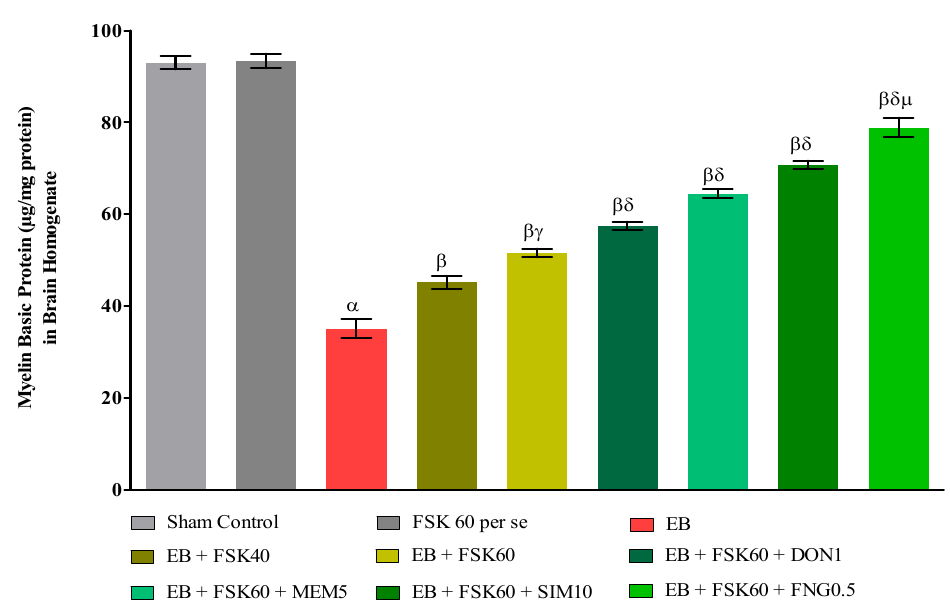
Figure 7. Protective role of FSK on restoration of myelin basic protein in experimental multiple sclerosis rats. Analysis of Variance (ANOVA) with Tukey’s test was used to evaluate the data, which were presented as mean with SD ( n = 6). α EB (p < 0.01) v / s Sham control and FSK40 perse; β EB